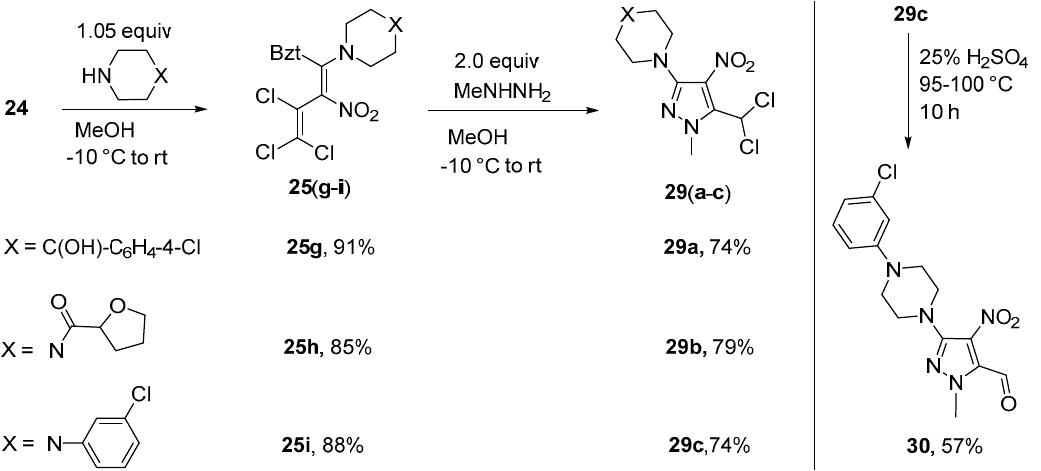
Molecules 2019 , 24 , × FOR PEER Scheme 8. Synthesis of pyrazoles 29 , 30 and benzotriazoles 25 . Scheme 8. Synthesis of pyrazoles 29 , 30 and benzotriazoles 25 .